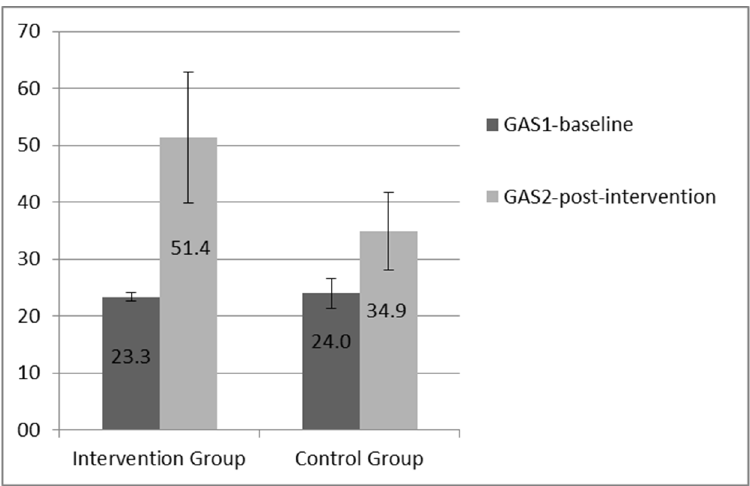
Figure 1. Mean GAS T-scores pre- and post-intervention. Intervention G: GAS1 mean = 23.3 (SD 0.74); GAS2 mean = 51.4 (SD 11.44). Control G: GAS1 mean = 24.0 (SD 2.58); GAS2 mean = 34.9 (SD 6.83).